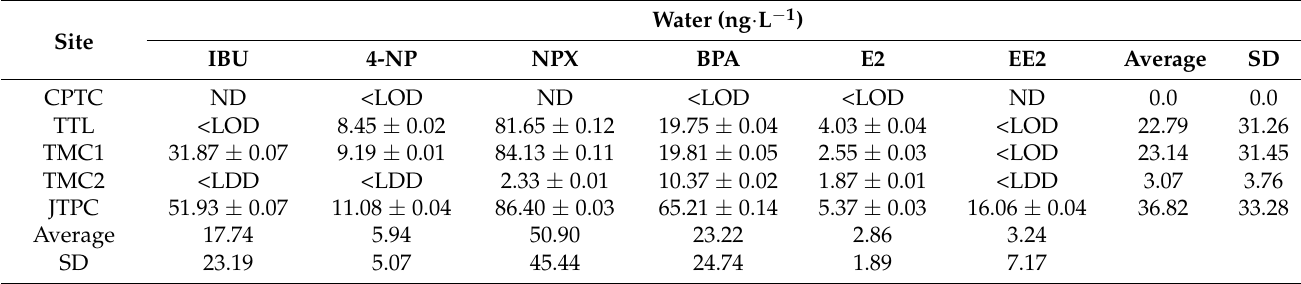
Table 4. Environmental concentrations of drugs and CDEs determined in surface water and natu- ral